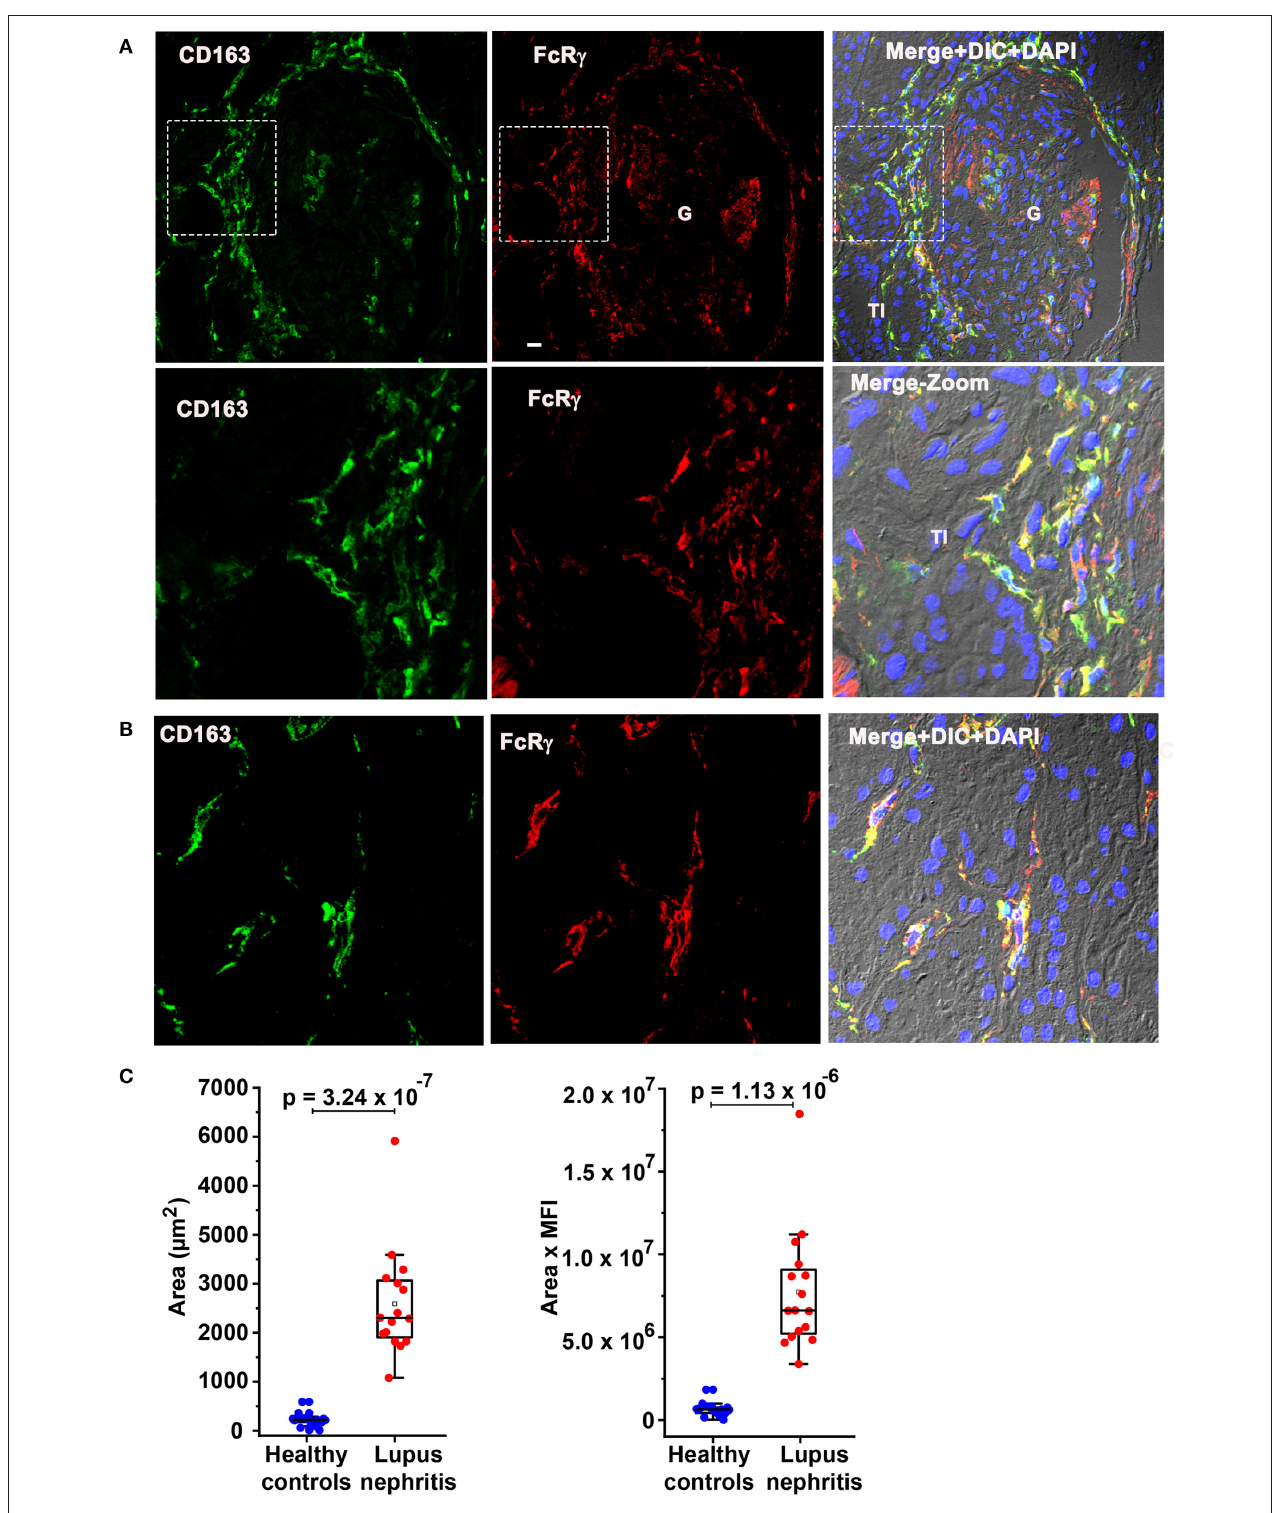
FIGURE 6 | Fc receptor gamma chain colocalizes with previously identified circulating inflammatory dendritic cell (infDC) marker CD163 and CD163 expression is overexpressed in human LN compared to HCs. (A) Three color IF images that are representative of 3 human LN kidneys showing colocalization of CD163 in